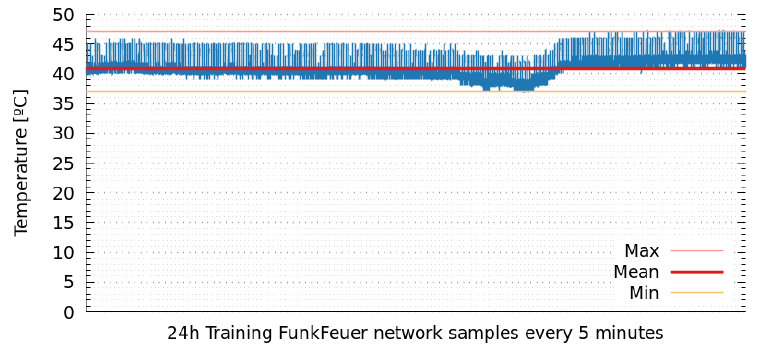
Figure 21. Temperature variation for Training WEKA model every 5 min in a period of 24 h: mean is 40.84 ◦ C, maximum is 47 ◦ C and minimum is 37 ◦